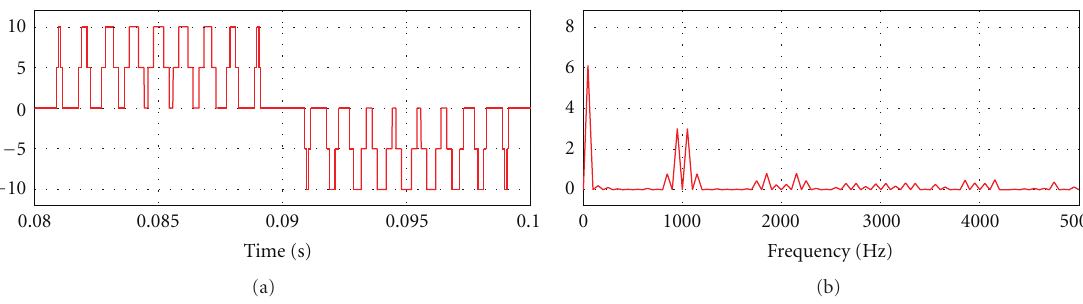
Figure 8: PWM output current waveform i inv and harmonic content of the proposed circuit operating at m pv / = m wind , I pv = I wind , f line = 50Hz and f sw = 1kHz.